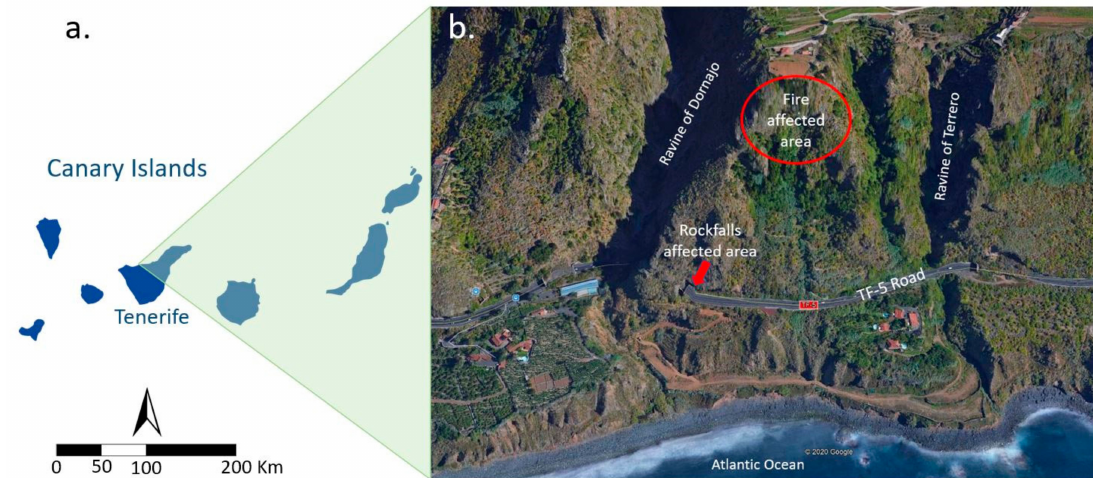
Figure 13. Location of the study area (Los Realejos, Tenerife). The TF-5 road and the fire location are shown (image created using © Google